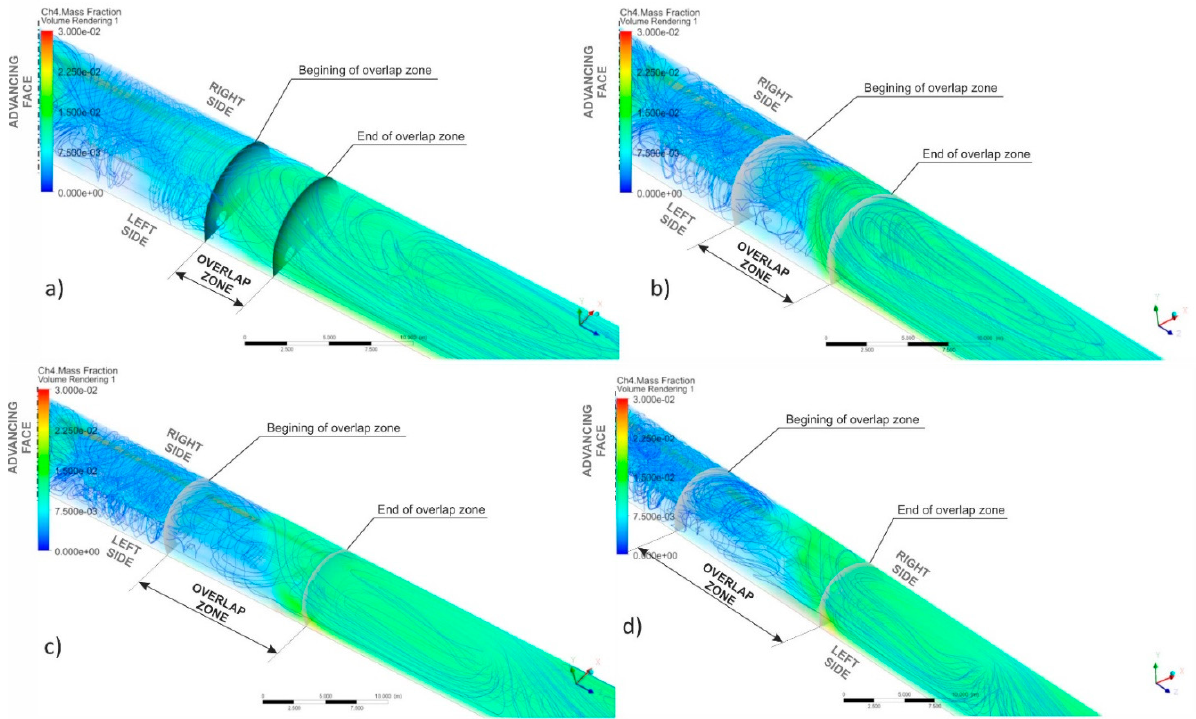
Figure 10. Methane concentration and velocity streamlines in overlap zone, ( a ) L o = 5 m, ( b ), L o = 10 m, ( c ), L o = 15 m, ( d ) L o = 20 m.